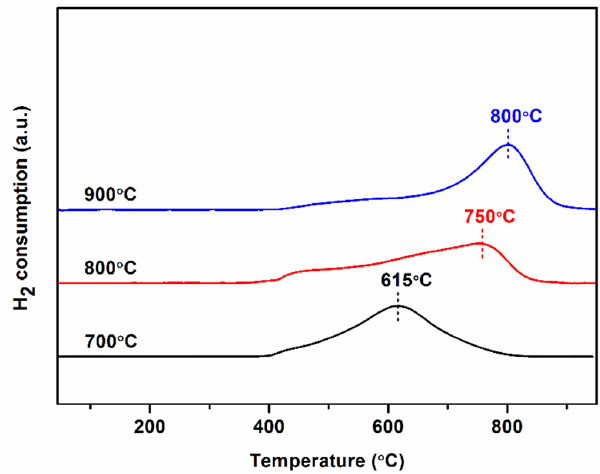
Figure 12. TPR profiles of the catalysts prepared at different calcination temperatures. Table 4. Reducibility and Ni dispersion of Ni/Al 2 O 3 catalysts.